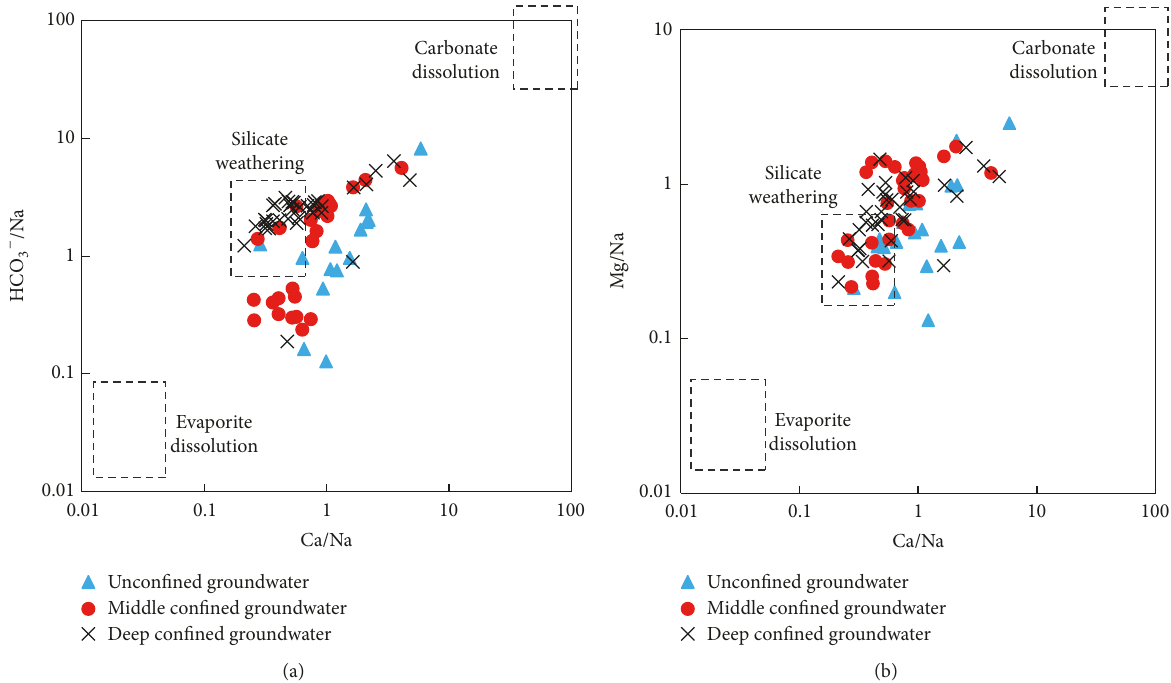
Figure 7: Bivariate plots of molar ratio. (a) Na-normalized Ca versus Na-normalized HCO 3 . (b) Na-normalized Ca versus Na-normalized